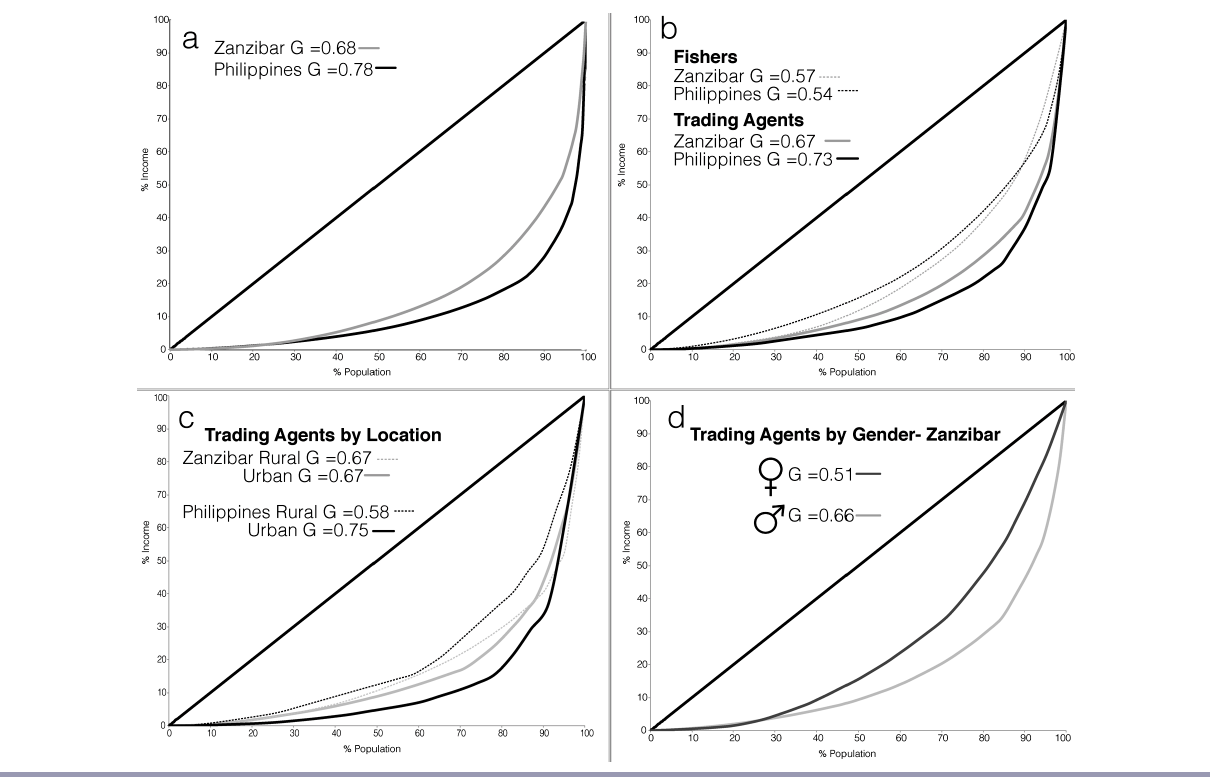
Fig. 3 . Lorenz curves for average daily incomes per respondent, reported with Gini Coefficients (G). Panels show income inequality (a) across all market actors, across the two countries; (b) among and between fishers and trading agents; (c) across traders operating in different locations in both countries; and (d) across traders of different gender in Unguja.